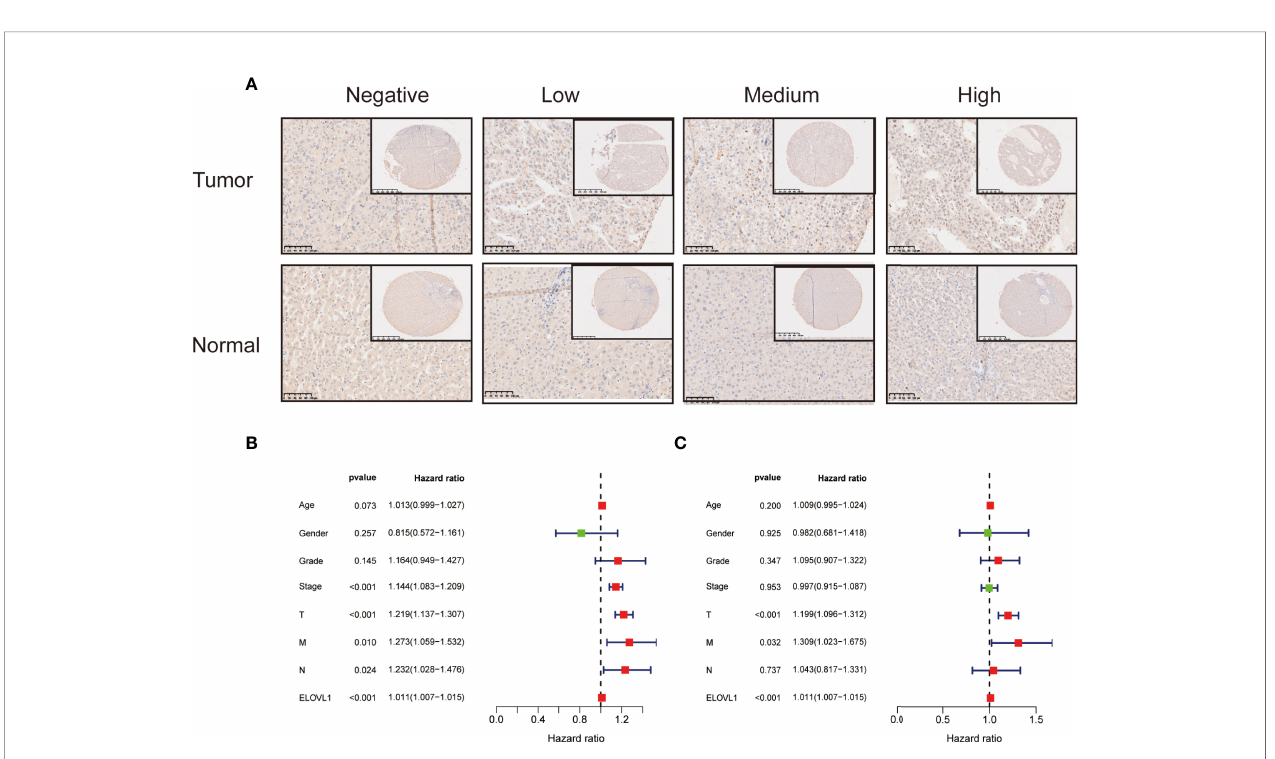
FIGURE 4 | The mRNA and protein expression of ELOVL1 in HCC tissues and the adjacent tissues. (A, B) Comparing the adjacent tissues, the relative mRNA expression of ELOVL1 was increased and ELOVL3 was not changed in HCC tissues. (C, D) Protein expression of ELOVL1in HCC tissues comparing to adjacent tissues. *P < 0.05. NS, Not Signi fi cant.